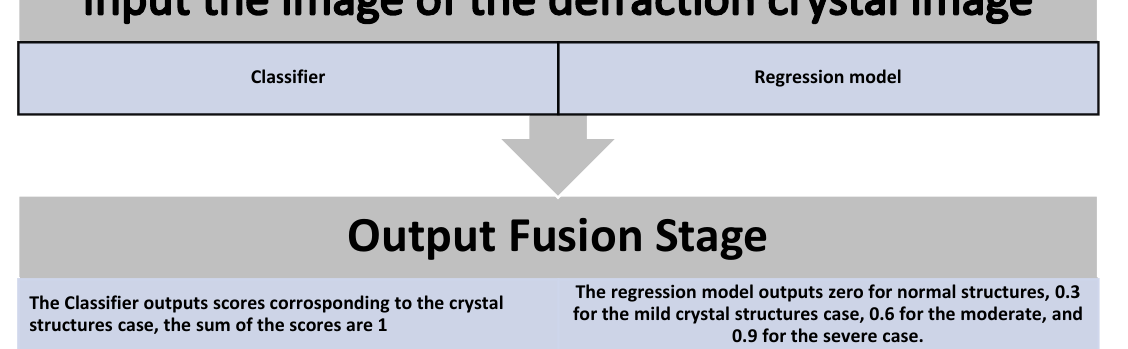
Figure 2. The proposed classifier and regression model, the images of the diffraction crystal images are fed as input for both the classifier and the regression model, and the outputs from both models are then fused.